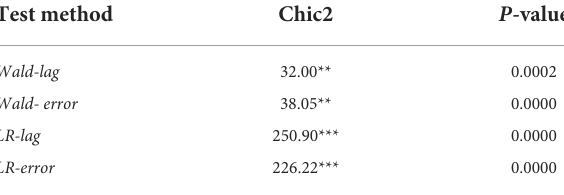
TABLE 8 Statistics and p -values of Wald and LR